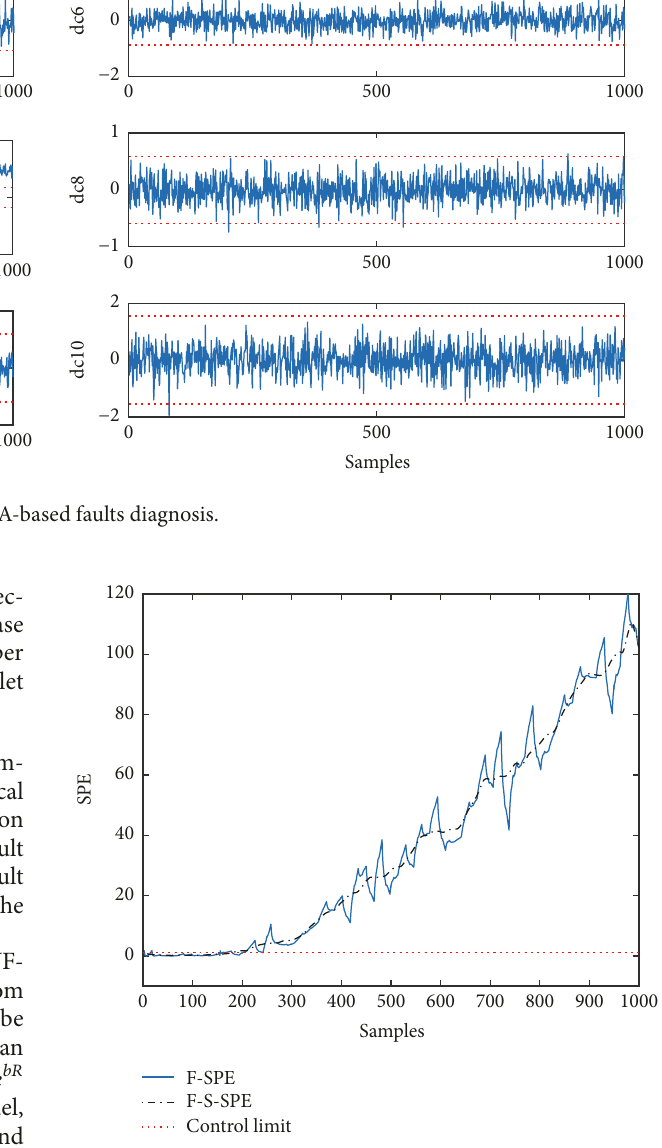
Figure 3: WF-PCA based early fault